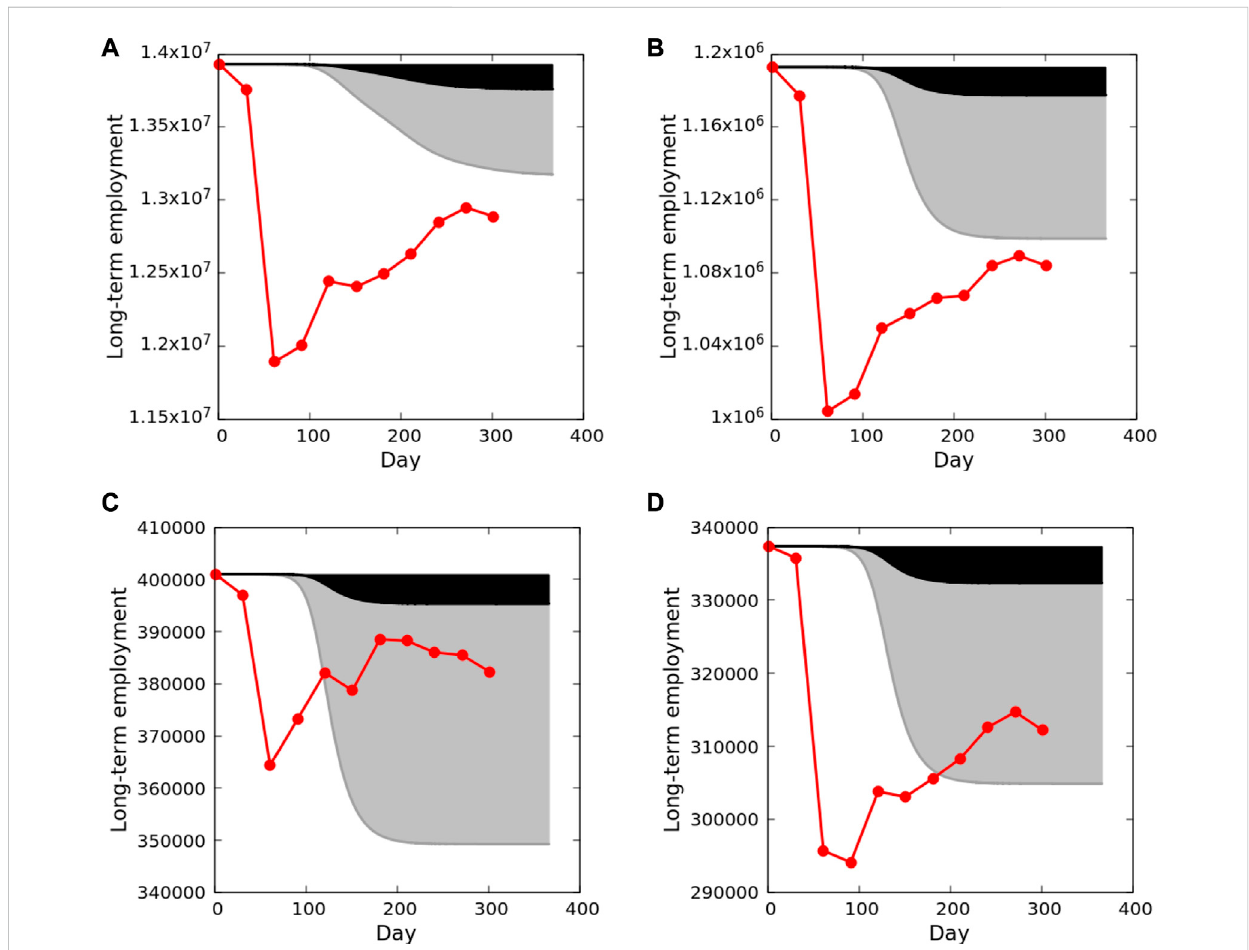
FIGURE 7 Comparisons of unemployment forecast by the business-as-usual model and actual unemployment of March to December, 2020. (A) — all SESs combined; (B) — SanFrancisco-SanMateo-RedwoodCity; (C) — Fresno; (D) — Oxnard-ThousandOaks-Ventura.Actualunemploymentisdepictedbysolid red lines, connecting actual monthly estimates (red circles). Model forecast unemployment of the business-as-usual scenario is the solid grey line, while the red line is actual unemployment. Model unemployment is partitioned between losses to the disease because of death or long-term illness, and unemployment caused by the cascading economic consequences; black and grey fi lled areas